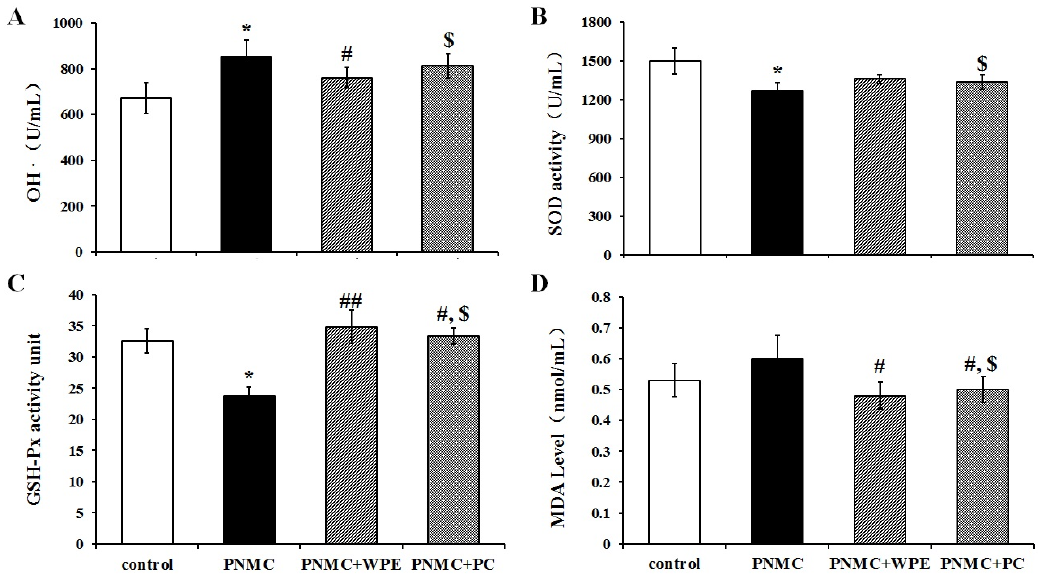
Figure 7. Effects of WPE on levels of ∙ OH, SOD, GSH ‐ Px, and MDA in splenocytes exposed to PNMC. Splenocytes were cultured in the presence of PNMC (10 − 4 M) or WPE(1.0 μ g/mL), PC (1.0 μ g/mL) together with PNMC for 48 hr. Changes in ( A ) hydroxyl free radical ( ∙ OH) activity; ( B ) superoxide dismutase (SOD) activity; ( C ) glutathione peroxidase (GSH ‐ Px) activity; and ( D ) malonaldehyde (MDA) content in the cells were measured using specific assay kits. Results shown are means ± SD of three separate experiments. * p < 0.05 vs. untreated control; # p < 0.05 or ## p < 0.01 vs. PNMC treatment; $ p < 0.05 vs. WPE (1.0 μ g/mL), together with PNMC (10 − 4 M) treatment.